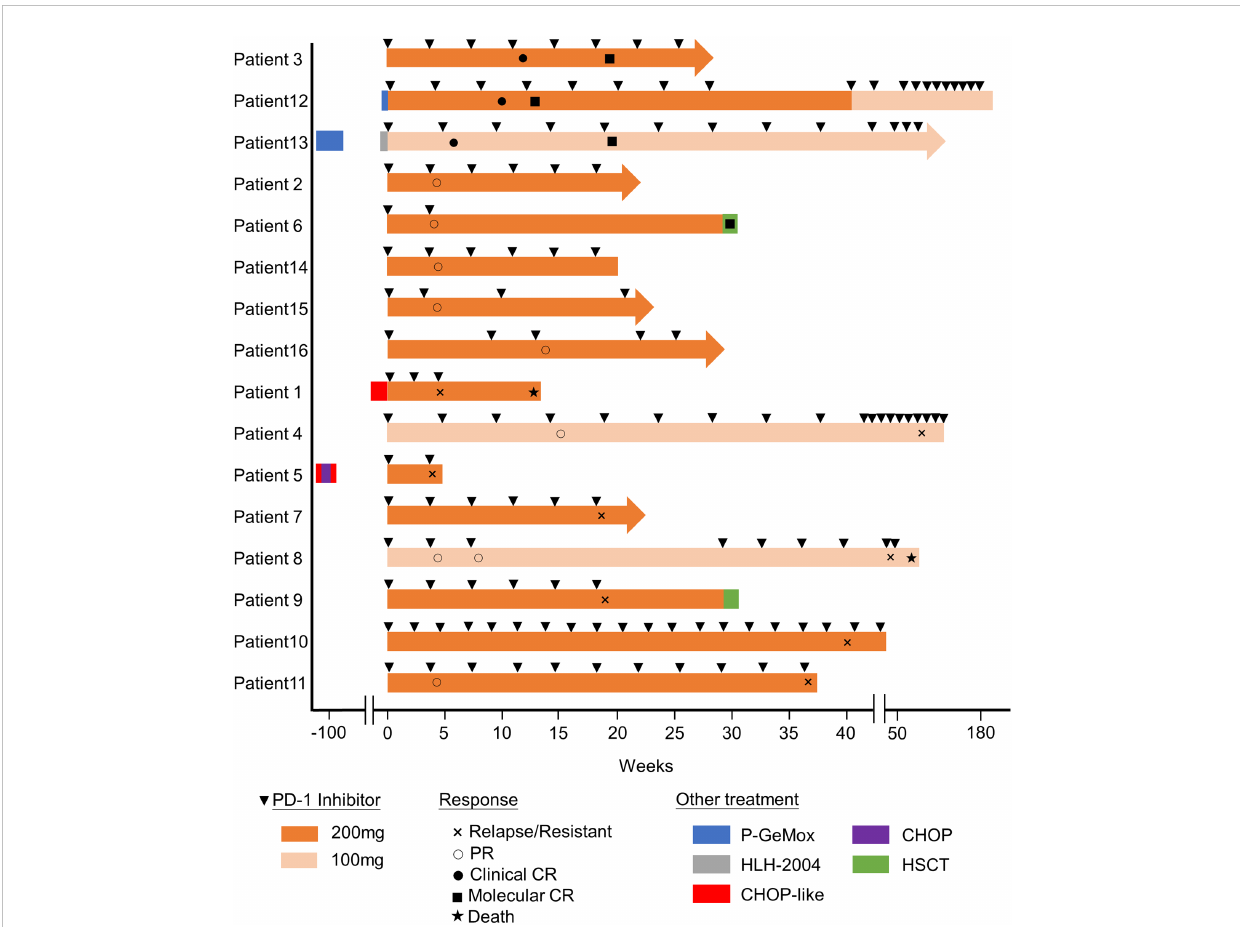
FIGURE 1 Swimmer plot of time on treatment of 16 CAEBV patients. P-GEMOX, pegaspargase, gemcitabine and oxaliplatin; CHOP, cyclophosphamide, doxorubicin, vincristine and prednisolone; HLH-2004, etoposide and